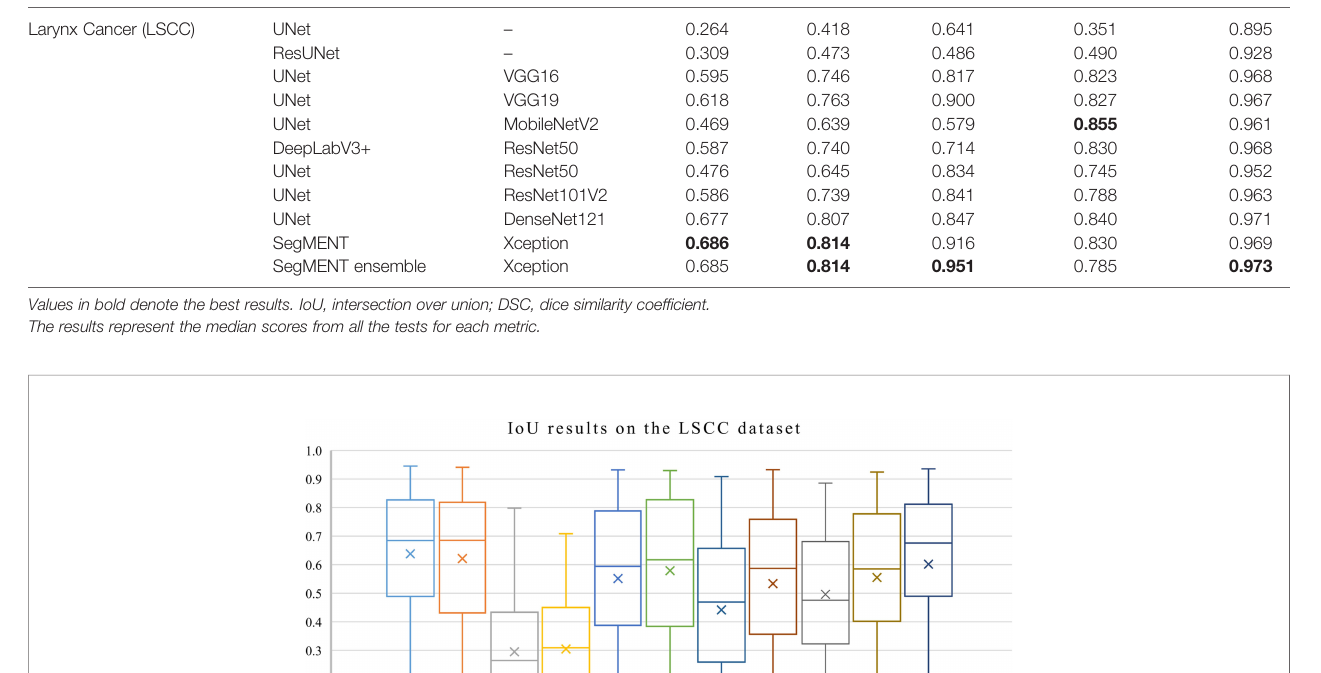
TABLE 2 | Performance evaluation of different semantic segmentation models during testing on the laryngeal squamous cell carcinoma (LSCC) dataset. Dataset Model Backbone DSC Recall Precision